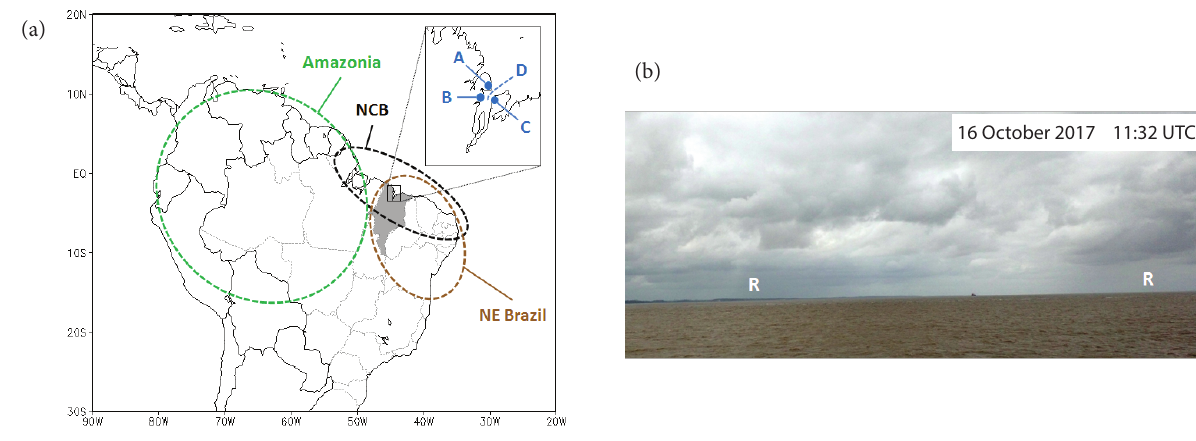
Figure 1. (a) The boundaries of Brazilian states are indicated by gray dotted lines. The State of Maranhão is shaded in gray. Dashed circles show the approximately location of the NCB (black), Northeast Brazil (brown) and Amazonia (green). The box-like region that includes the CLA is zoomed in and the approximately location of the CLA (A), Cujupe (B), São Luís (C) and São Marcos Bay (D) is shown; (b) Photograph of the west bank of São Marcos Bay, where the CLA region is located, taken during the crossing of São Luís to Cujupe by ferryboat. Areas under light precipitation are indicated with the letter “R”. These areas occur under extensive cloud cover. Therefore this work focuses on precipitation over the CLA region in the dry quarter, for which the main observational features are already